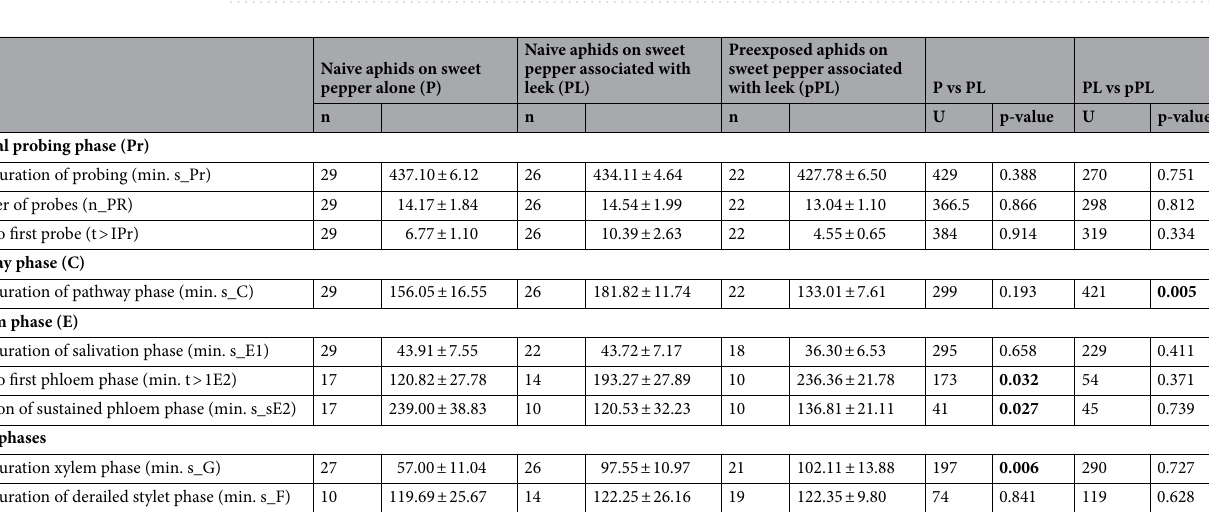
Figure 1. Behavioral responses (mean ± SEM) of M. persicae to contact, volatile and visual cues of sweet pepper alone (P) and sweet pepper associated with leak (PL) after 24 h. Ten aphids were allowed to disperse from leaves of a sweet pepper to an adjacent “choice plant” of the opposite status. Twenty replicates were performed for each condition. NS indicate a non-significant difference between sweet pepper and sweet pepper associated with leek (Mann–Whitney U-test).